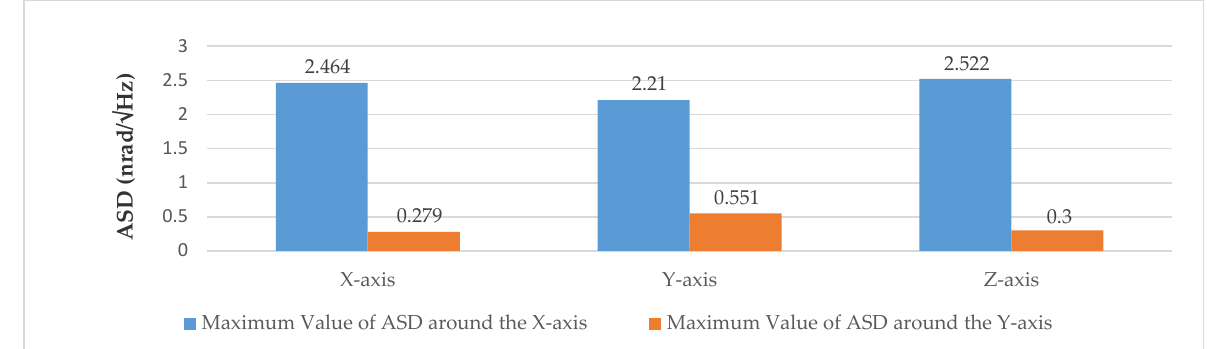
Figure 7. Amplitude spectral density corresponding to different heating directions.